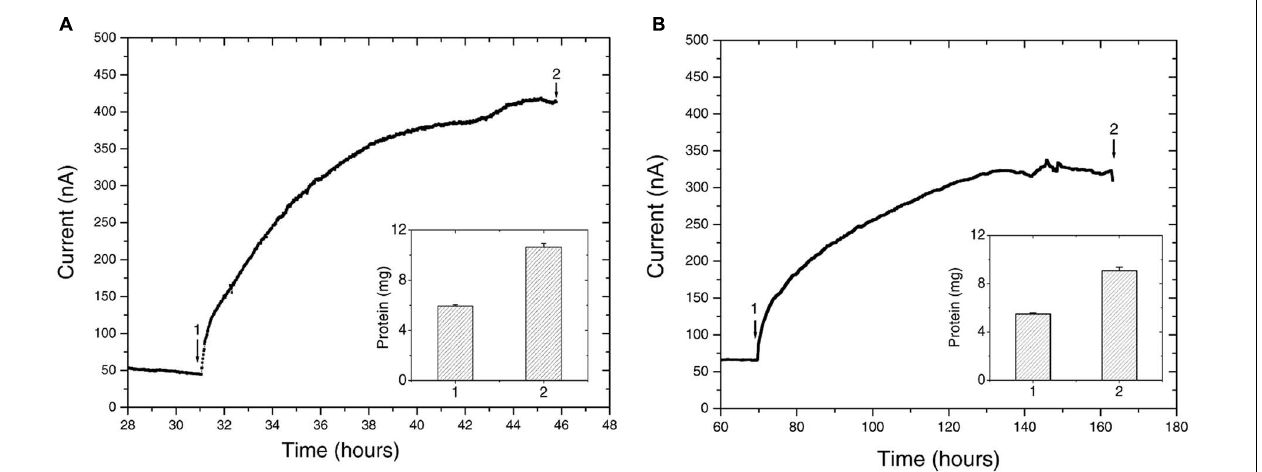
FIGURE 5 | Chronoamperometry of the isolated strains (A) Delftia sp. WE1-13, (B) Azonexus sp. WE2-4. In both cases, the WE was poised at 522 mV vs SHE, acetate (10 mM) was used as electron donor, and reactors were purged with N 2 to maintain anaerobic conditions. Insets show the total protein content measured at time points labeled 1 and 2.